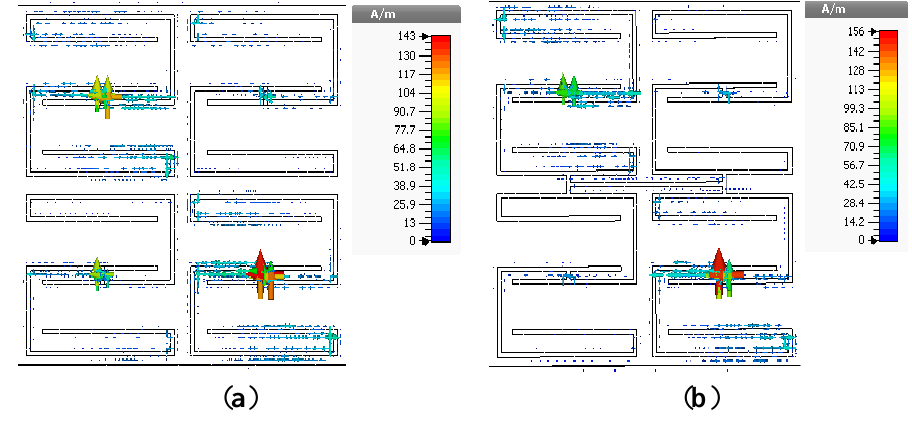
Figure 11. Surface current distributions of 2 × 2 arrays of unit cell C at 3.5 GHz: ( a ) open array and ( b ) interconnected array.